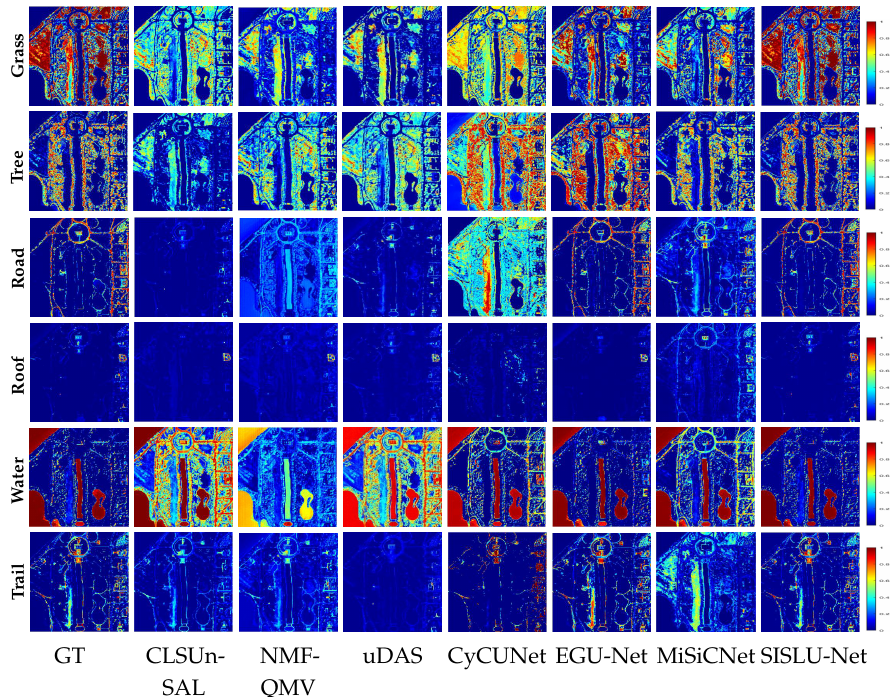
Figure 13. Estimated abundances by all competing methods on the Washington DC Mall Dataset.